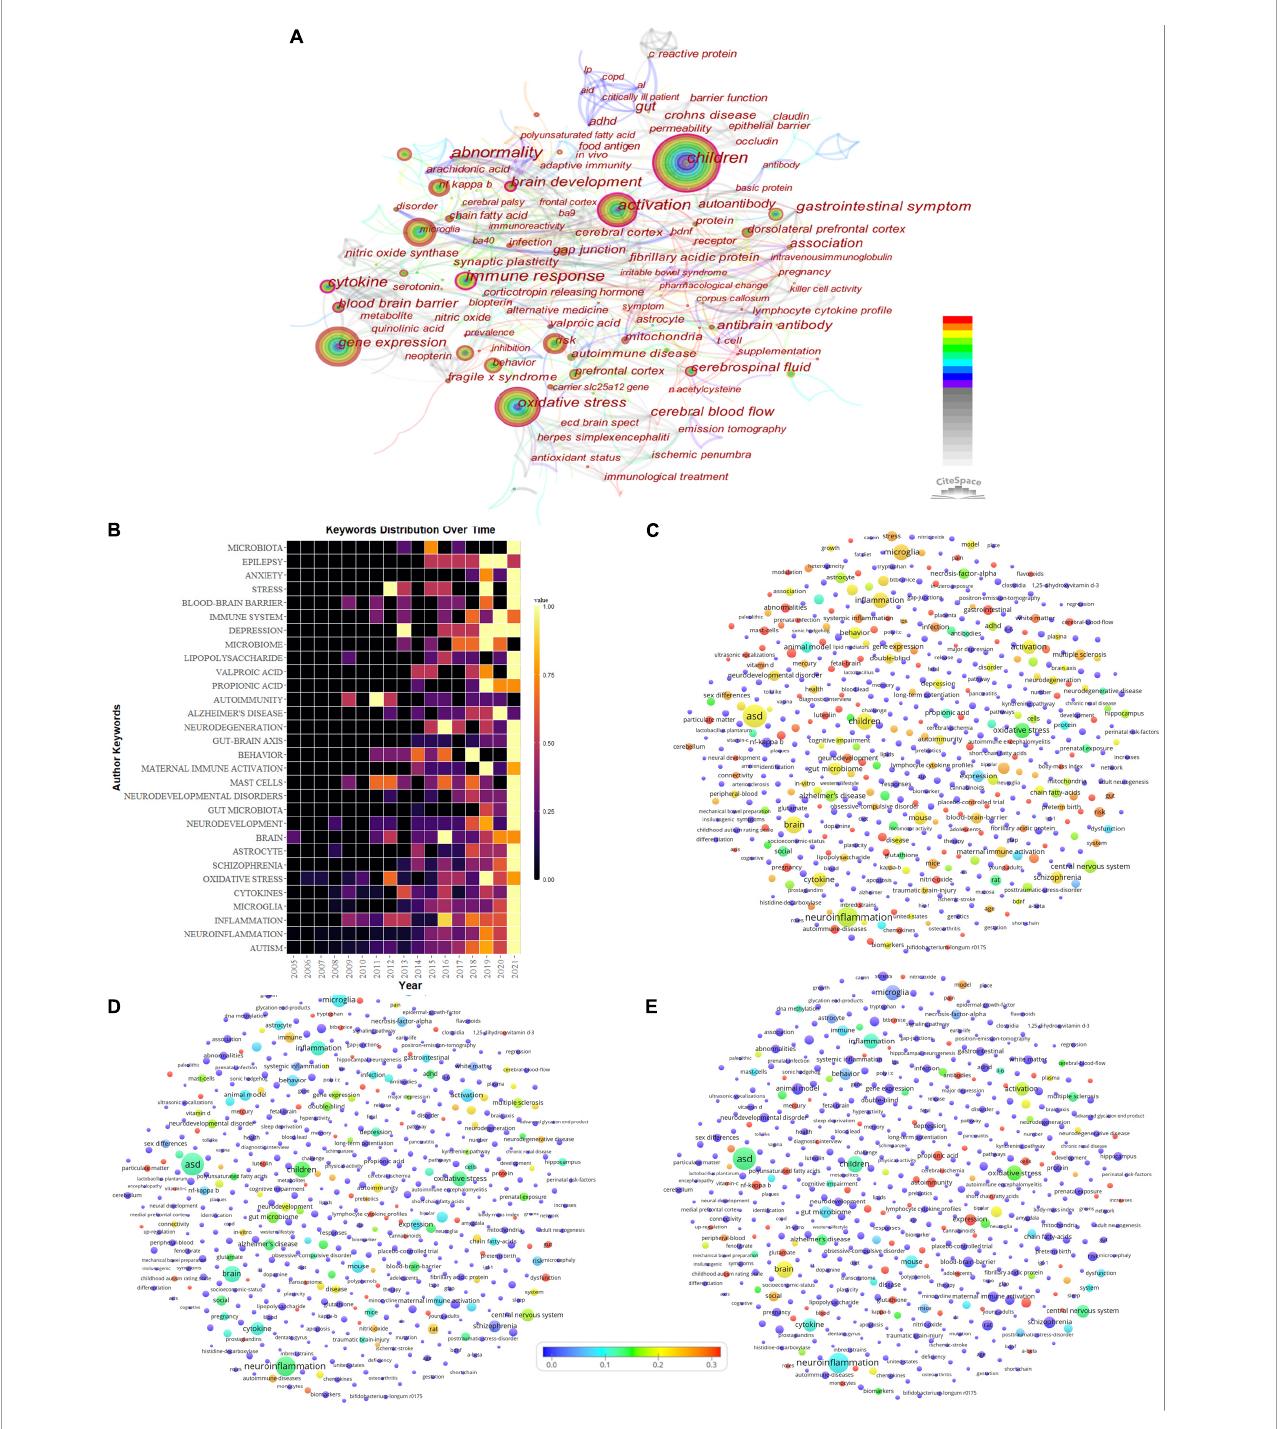
FIGURE7 Analysis of the research hotspots. (A) Network visualization of author keywords. (B) Heat map of top 30 keywords’ frequency over time. (C) Map of US keyword frequency superimposed on world keyword frequency. (D) Map of Italy keyword frequency superimposed on world keyword frequency. (E) Map of Saudi Arabia keyword frequency superimposed on world keyword frequency. Panels (C–E) show the contribution of country keywords in this field to global